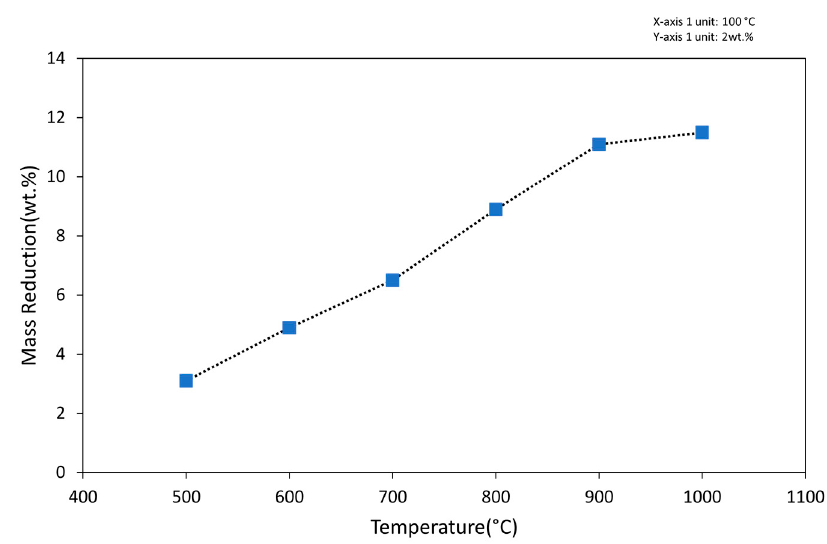
Figure 6. Mass loss against reduction temperature at constant H 2 gas flow rate.